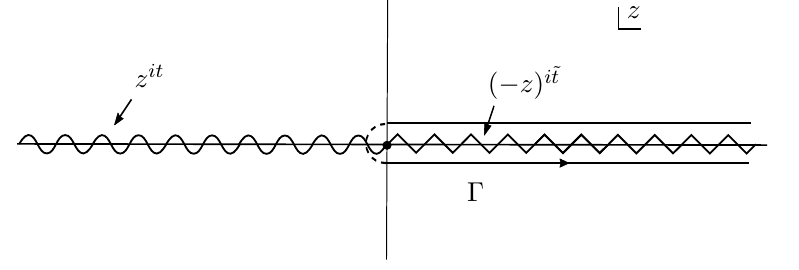
Figure 2 . Contour for the integral (3.7), with the associated branch cuts indicated. As explained in the text, the regularisation yields the integrand bounded around the origin, and thus the contri- bution the along the dashed semicircles vanish.